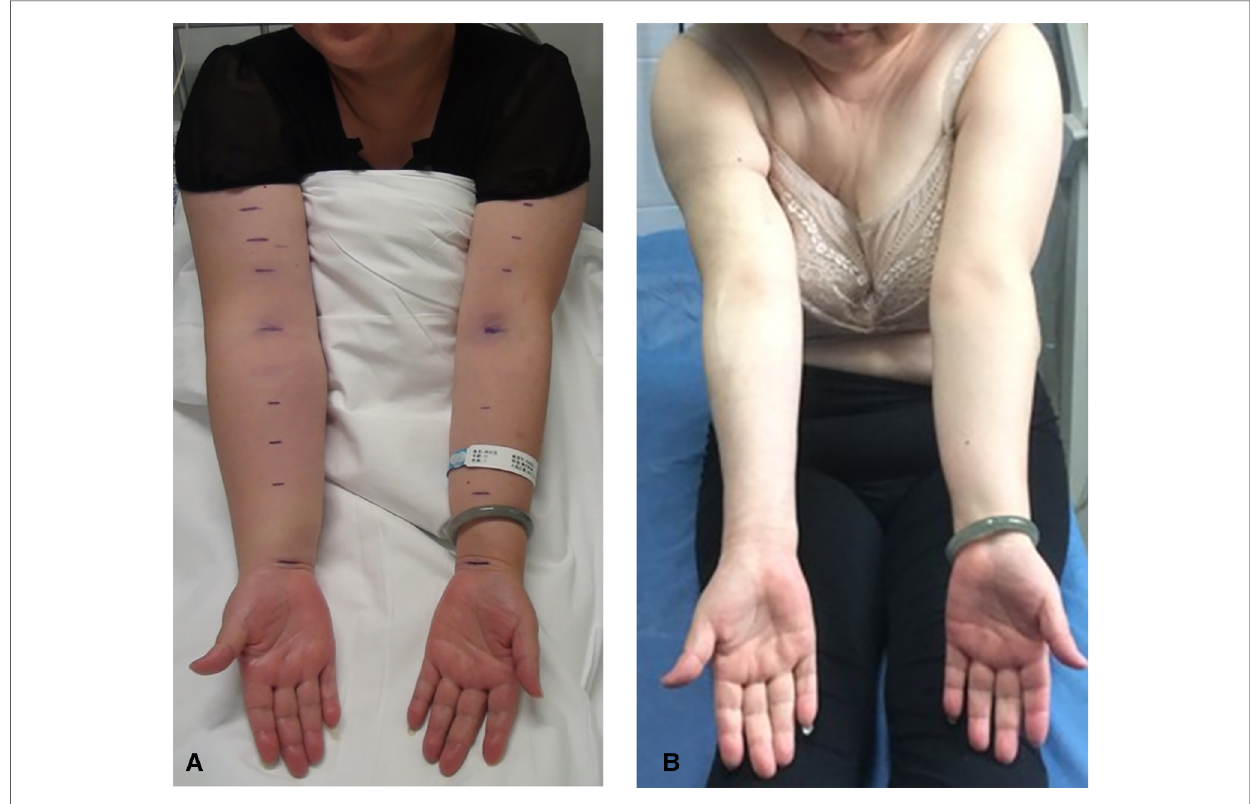
FIGURE 3 Female, 49 years old, right-sided BCRL: ( A ) before treatments (i.e., combination of liposuction and lymphovenous anastomosis), with the volume increase rate of 45.5%, and ( B ) 32 months after treatments, with the volume increase rate of − 11.7%. BCRL, breast cancer-related lymphedema.